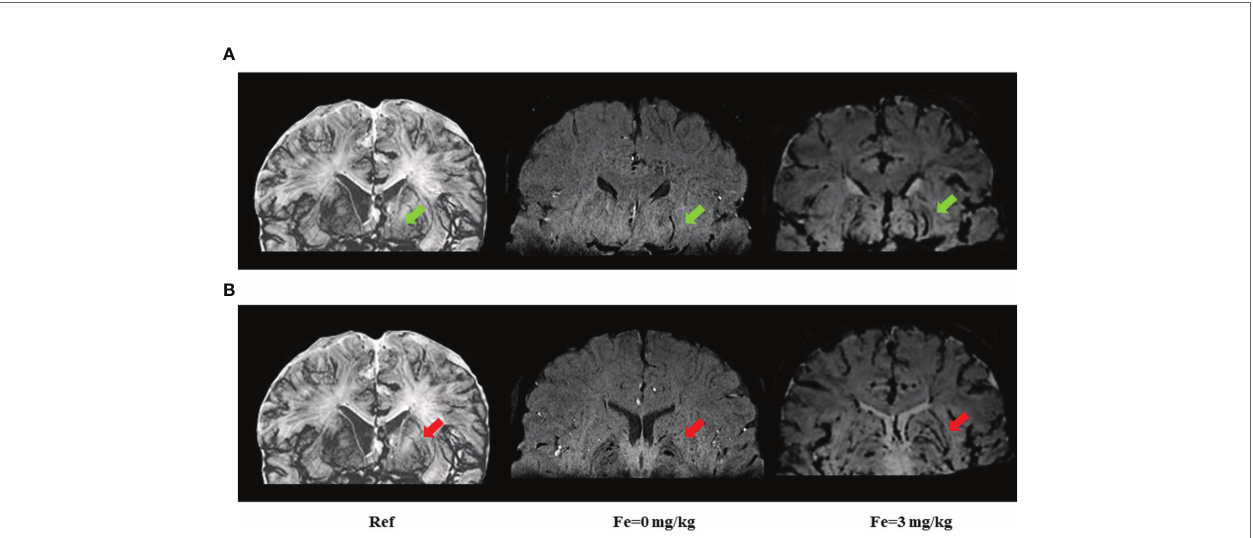
FIGURE 2 | Imaging of medial and lateral lenticulostriate arteries (LSAs) before and after ultrasmall superparamagnetic iron oxide (USPIO) enhanced susceptibility- weighted imaging (SWI) on 3-Tesla MRI. The medial and lateral LSAs were reconstructed in the coronal view of SWI. All images were minimum intensity projected (mIP) with an effective slice thickness of 8 mm. (A) green arrows point to the medial LSAs; (B) red arrows point to lateral LSAs. Ref: reference pictures were adapted from Salamon ’ s histology work (19) and could also be available online at Salamon ’ s Neuroanatomy and Neurovasculature Web-Atlas Resource (http://www.radnet. ucla.edu/sections/DINR/index.htm, Neurovasculature > Atlas of Brain Arteries (Frontal Section) > Atlas > Slide 15); Fe=0 mg/kg: plain scan without USPIO enhancement; Fe=3 mg/kg: USPIO enhancement scan with a concentration of 3 mg/kg of Fe. USPIO-SWI imaged the LSAs more clearly compared with conventional SWI